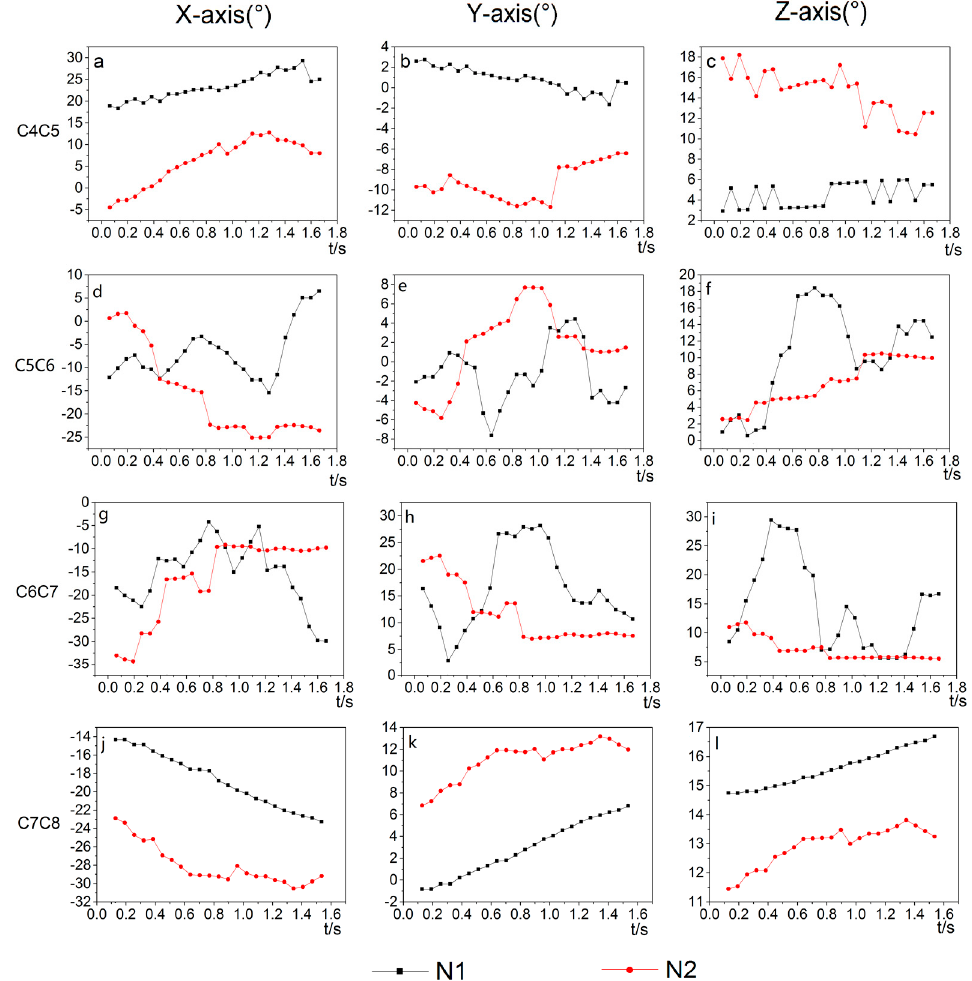
Figure 6. The angular three-dimensional displacements of joints C4/C5, C5/C6, C6/C7, and C7/C8 for two representative trails (N1, N2): ( a–c ) angle of C4/C5 around X, Y and Z axes, ( d–f ) angle of C5/C6 around X, Y and Z axes, ( g–i ) angle of C6/C7 around X, Y and Z axes, ( j–l ) angle of C7/C8 around X, Y and Z